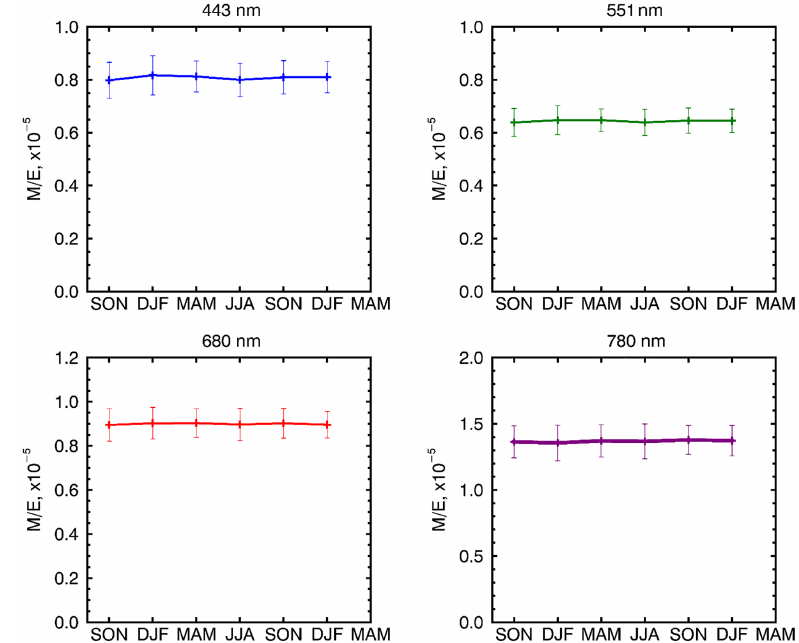
Figure 8. Seasonal dependence of the EPIC Version 2 calibration coefficients from September 2015 to February 2017. Whiskers represent the standard deviation of M/E ratios within each 3-month period.